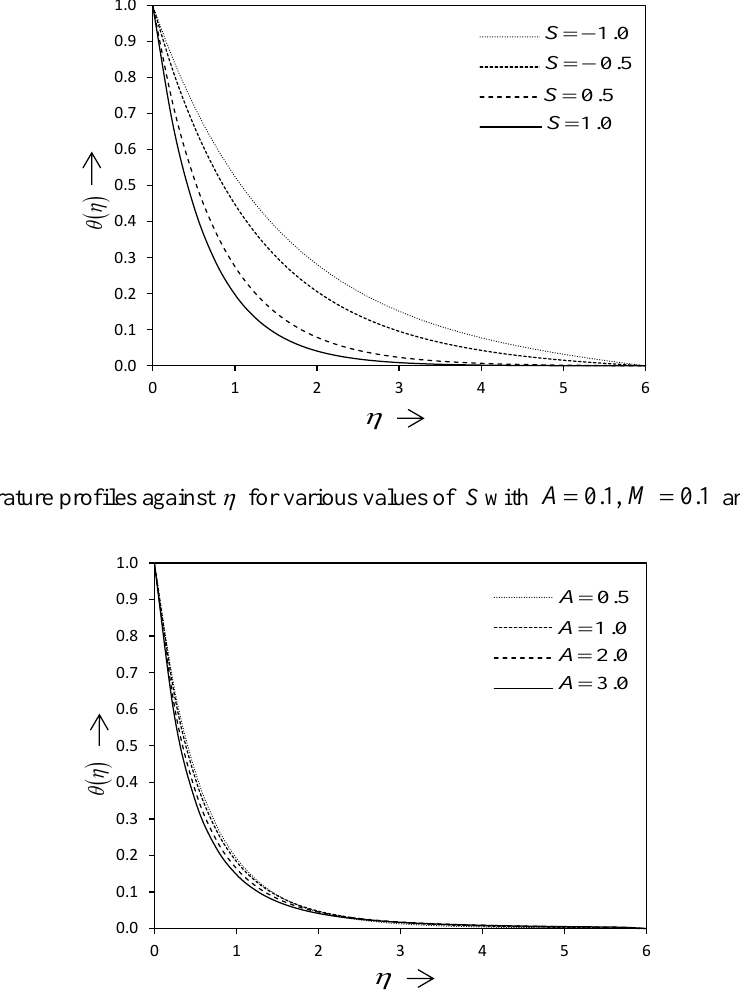
Figure 6. Temperature profiles against  for various values of A with 1.0,0.1 